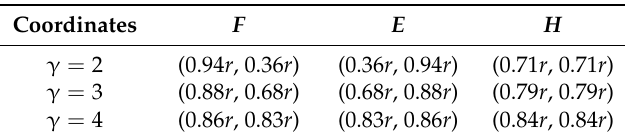
Table 3. The coordinates of E , F and H.